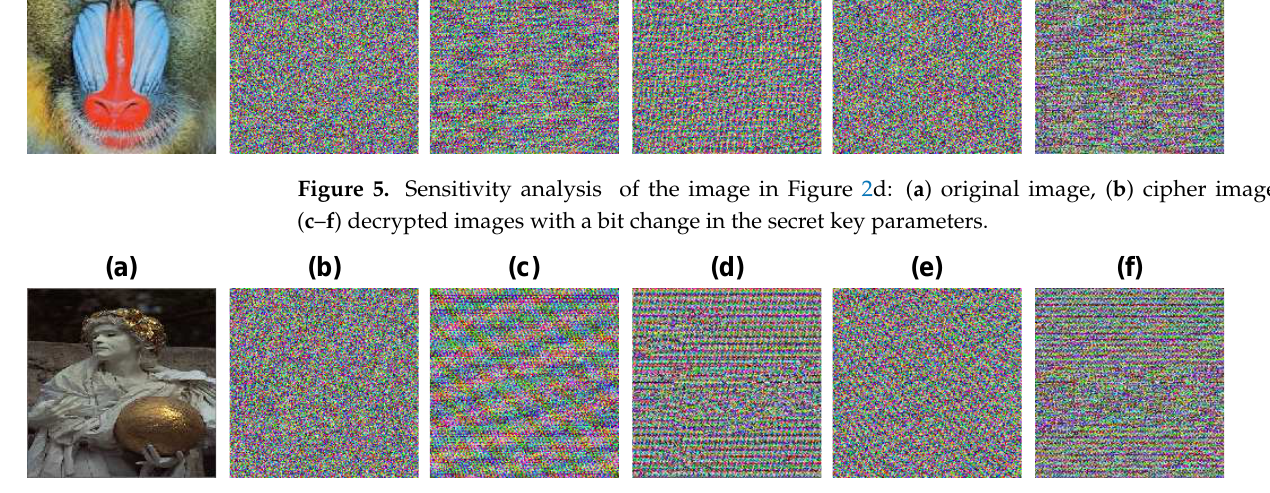
Figure 6. Sensitivity analysis of the image in Figure 2f: ( a ) original image, ( b ) cipher image, ( c – f ) decrypted images with a bit change in the secret key